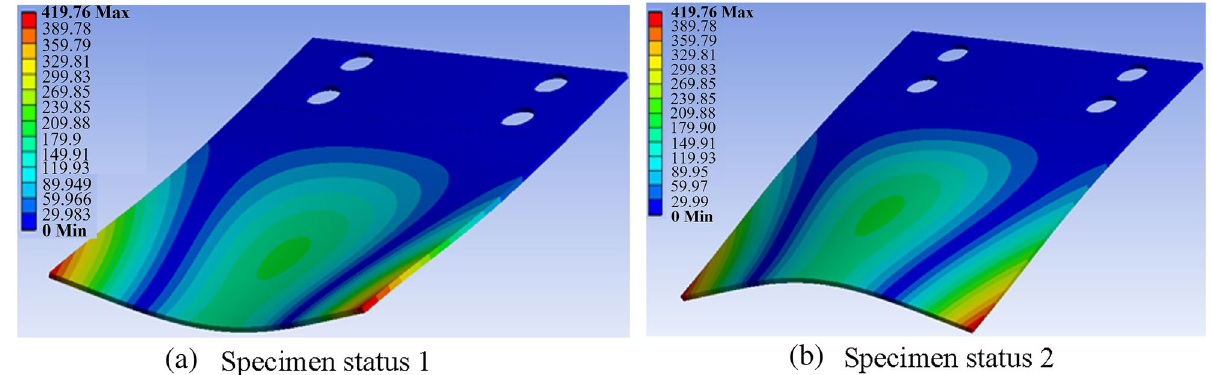
Figure 9. Deformation of the specimen in the fourth order vibration